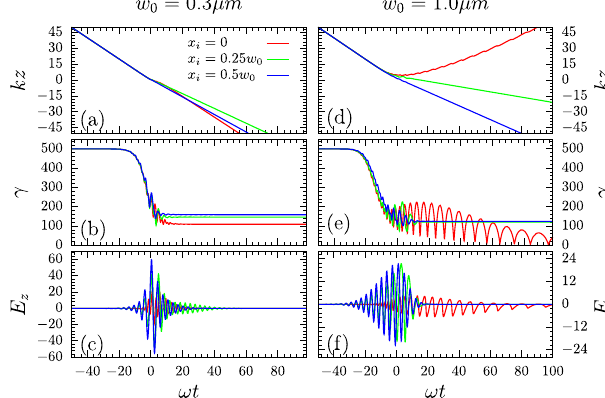
15. Electron dynamics for three different focusing param- eters, with RR included. These are w 0 ¼ 0 . 3 μ m ( θ 0 ¼ 0 . 85 ), w 0 ¼ 0 . 5 μ m ( θ 0 ¼ 0 . 51 ), and w 0 ¼ 1 . 0 μ m ( θ 0 ¼ 0 . 25 ). In all cases the laser is modeled as a paraxial beam of peak intensity a 0 ¼ 200 , wavelength 0 . 8 μ m and duration 27 fs. The electron right hand panel shows the longitudinal electric field (normalized = ω 0 m ) as experienced by the particle. to eE z